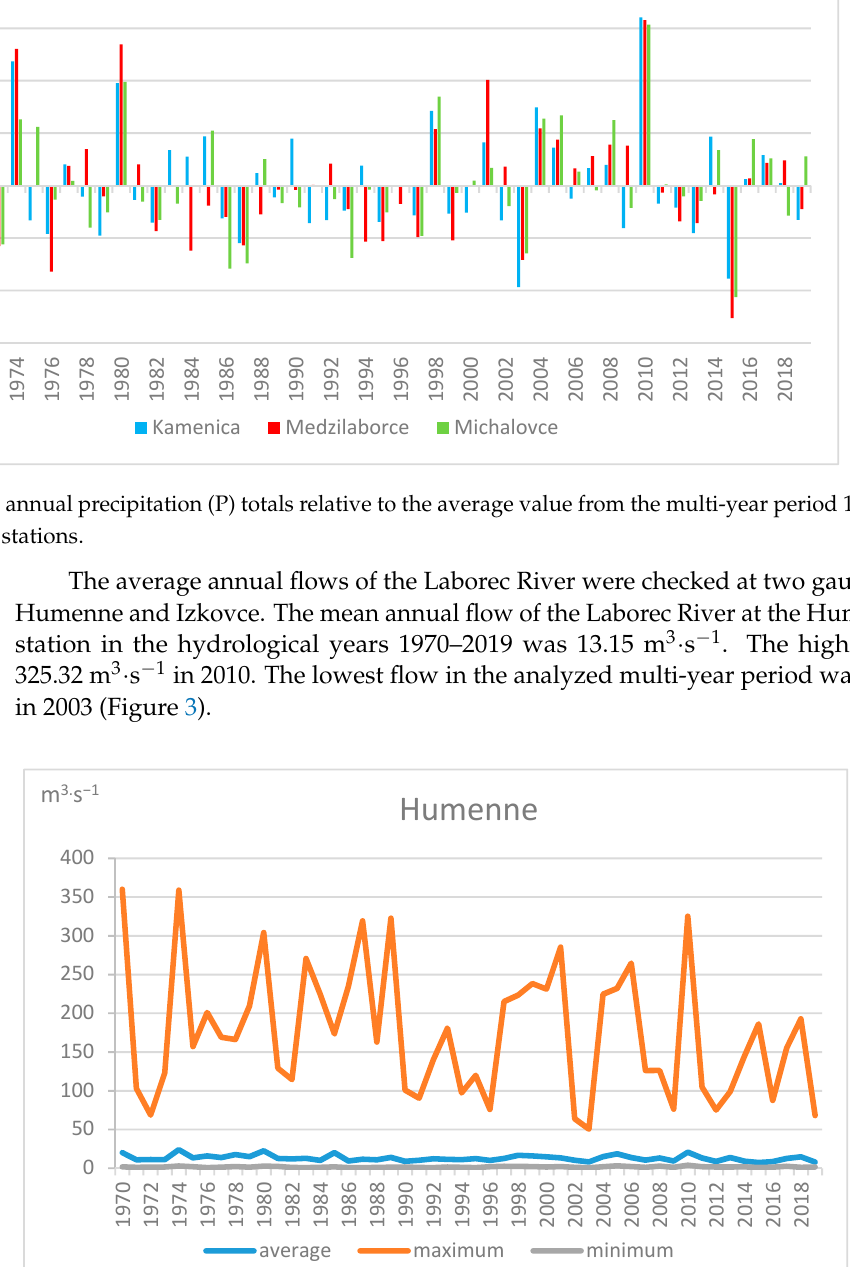
Figure 2. Anomalies of the annual precipitation (P) totals relative to the average value from the multi-year period 1970– 2019 at selected meteorological stations.